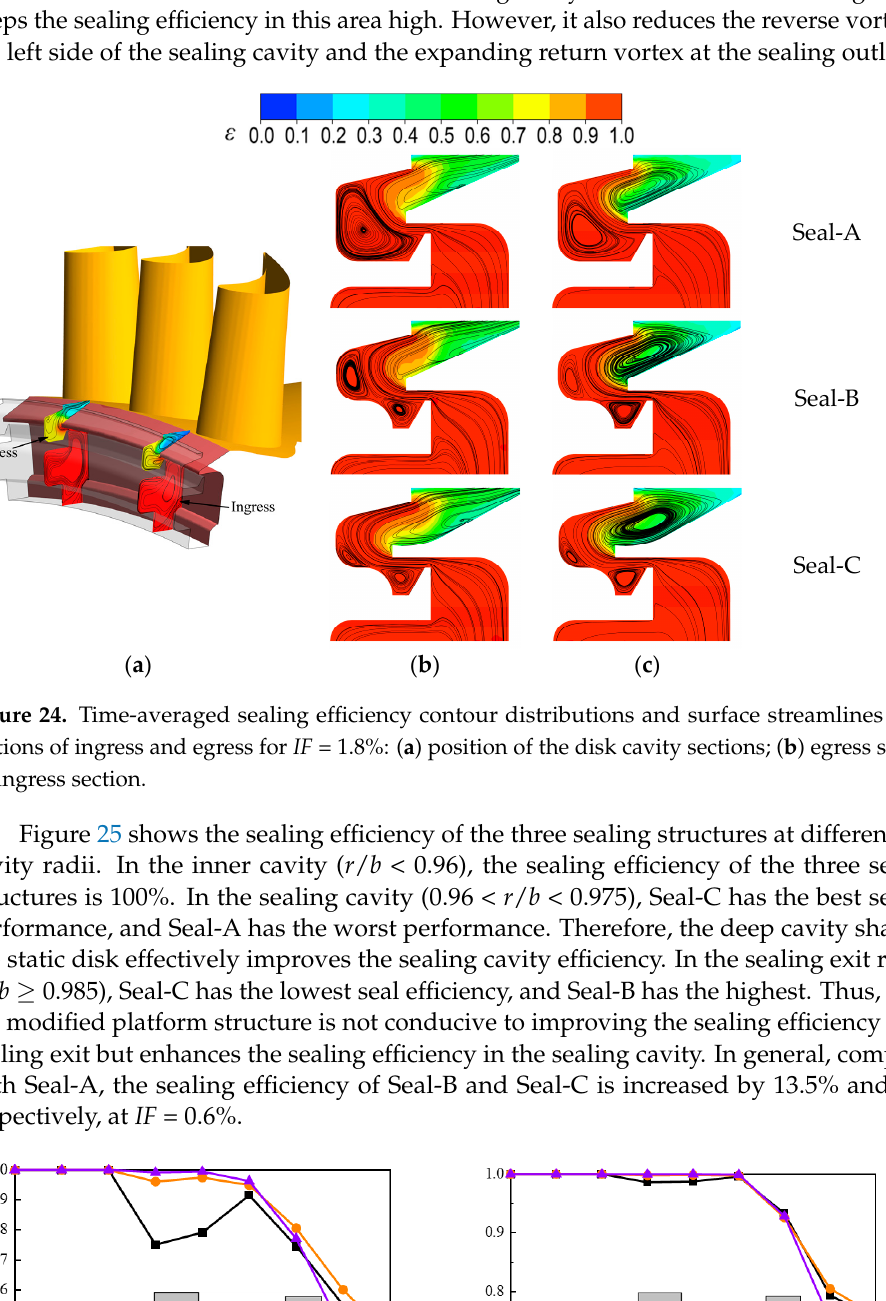
Figure 23. Time-averaged sealing efficiency contour distributions and surface streamlines at the sec- tions of ingress and egress for IF = 0.6%: ( a ) position of the disk cavity sections; ( b ) egress section; ( c ) ingress section.